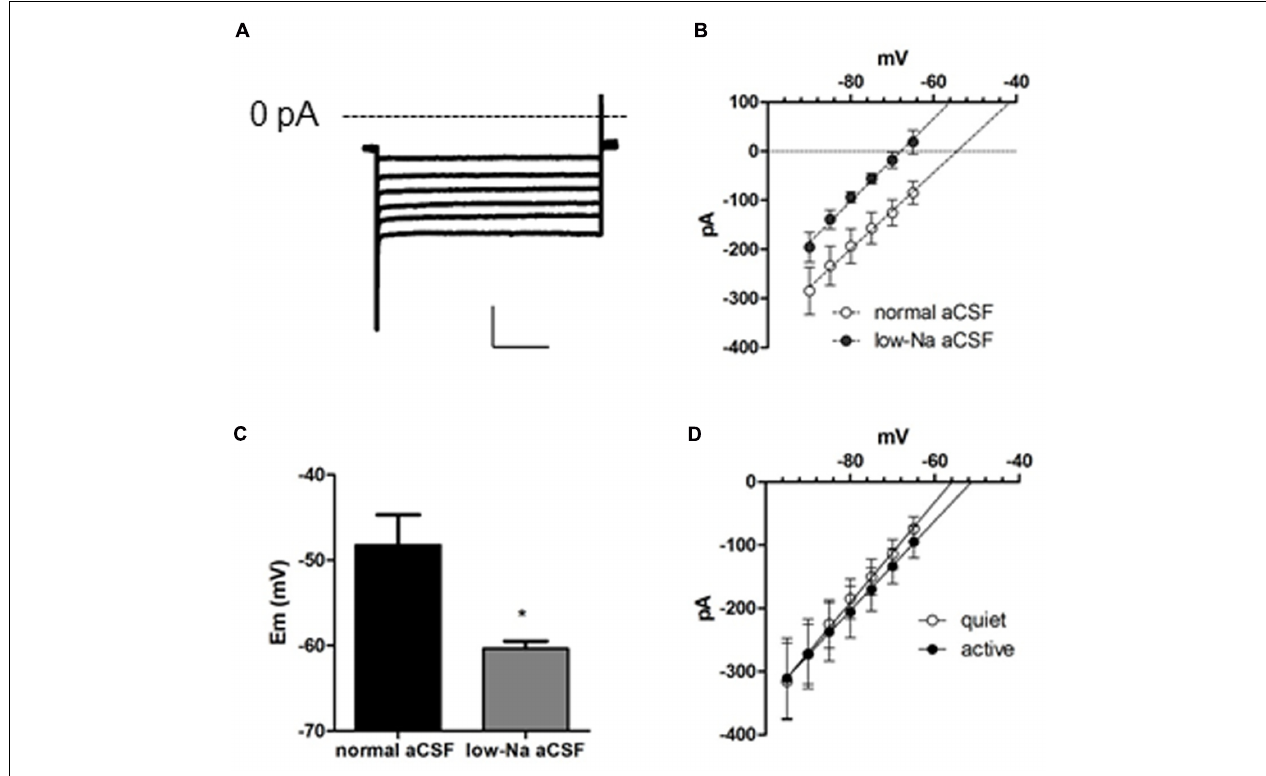
FIGURE 3 | A background conductance tonically depolarizes quiet and active fusiform neurons. (A) Example of the subthreshold currents evoked by membrane hyperpolarizations after blocking I Kir , I h , and I NaP with Ba ++ (200 µ M), ZD7288 (20 µ M), and TTX (1 µ M). (B) IV plot of the membrane currents of fusiform neurons recorded in the presence of Ba ++ (200 µ M), ZD7288 (20 µ M), and TTX (1 µ M) in control aCSF and in low-sodium aCSF. The lines are linear regressions to the data. (C) Summary of the effect of a low-sodium aCSF on the resting membrane potential (RMP) of fusiform neurons recorded in the presence of Ba ++ (200 µ M), ZD7288 (20 µ M), and TTX (1 µ M). ∗ p < 0.05, paired t -test. (D) Plot of the membrane currents of quiet and active fusiform neurons recorded in the presence of Ba ++ (200 µ M), ZD7288 (20 µ M), and TTX (1 µ